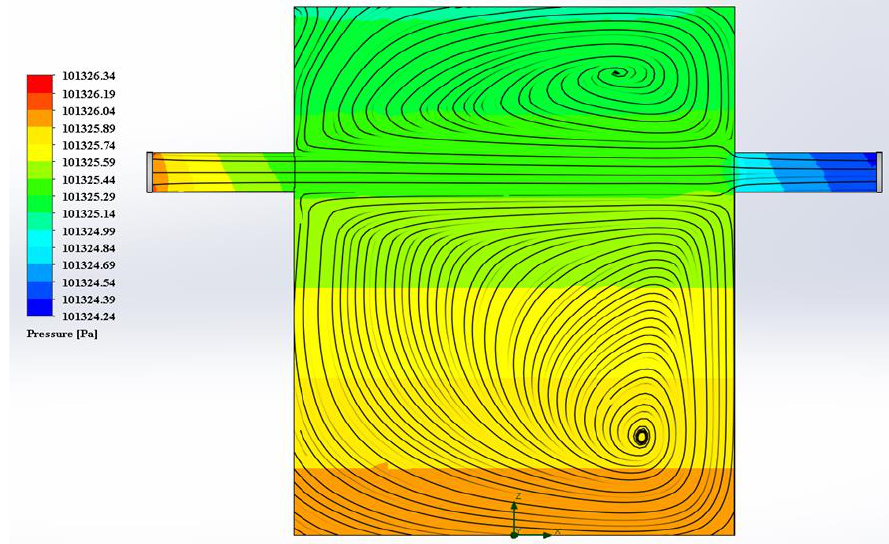
Figure 15. Internal pressure in the reaction cell and current lines, in run 1, for the geometry with lateral air inlet and outlet. Q = 1.5 L/min; Di RC = 6.0 cm; D I = 2.5 cm; D O = 2.5 cm.